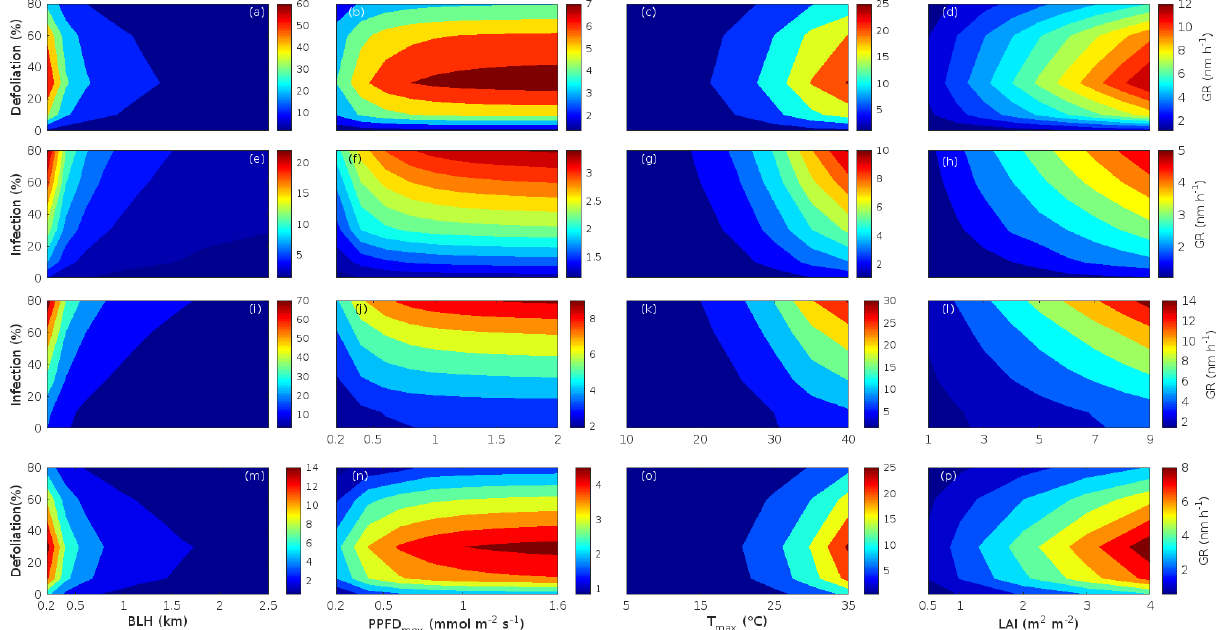
Figure D1. Impact of changed boundary conditions on the growth rate of small particles in non-infected and biotically stressed forest stands. The subplots correspond to those in Fig. 10, but the subplots here display growth rate instead of the number of particles. Thus, we refer the reader to Fig. 10 for further details.